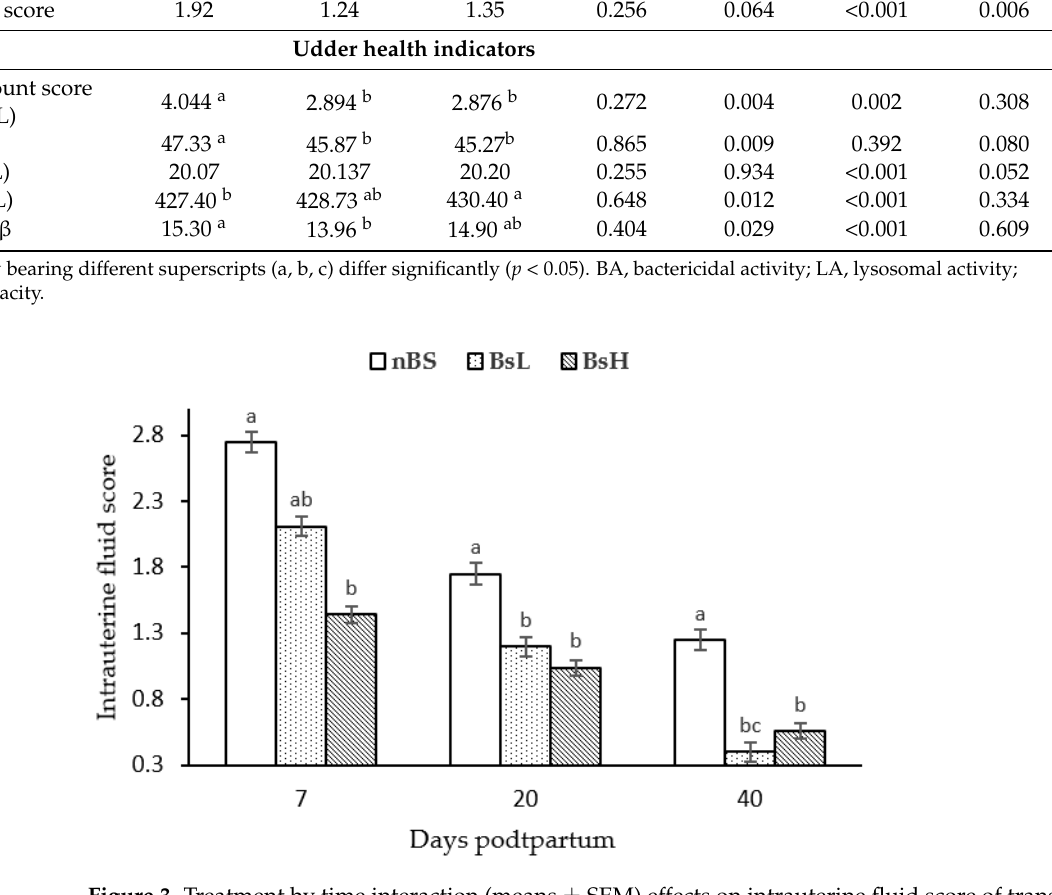
Figure 3. Treatment by time interaction ( means ± SEM) effects on intrauterine fluid score of